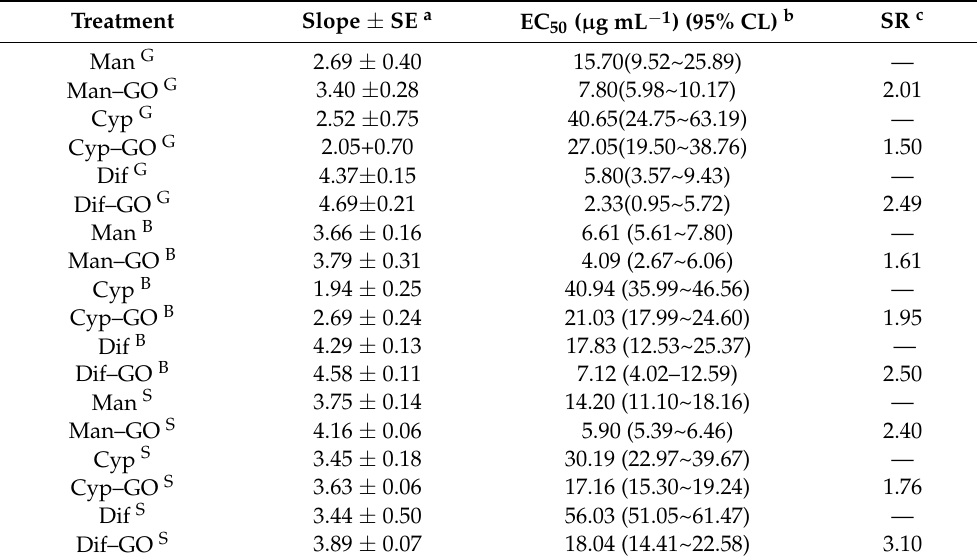
Table 2. EC 50 values of fungicides and GO–fungicides for inhibiting the mycelial growth, mycelial biomass and spore germination of F. graminearum